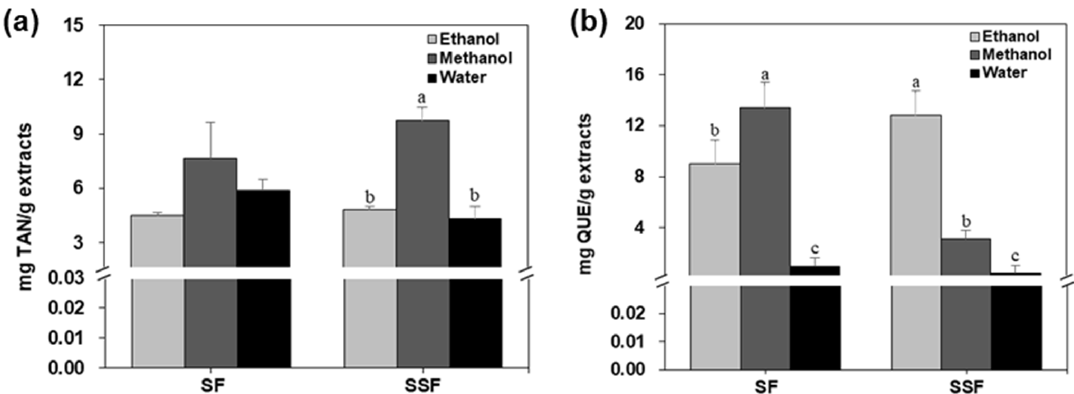
Figure 1. Total polyphenol ( a ) and flavonoid ( b ) contents in ethanol, methanol, and water extracts of fresh and steamed Sargassum fusiforme . SF: S. fusiforme extract, SSF: Steamed S. fusiforme extract, TAN: Tannic acid, QUE: Quercetin. The different lowercase letters represent significant differences between solvents within the same sample ( p < 0.05).